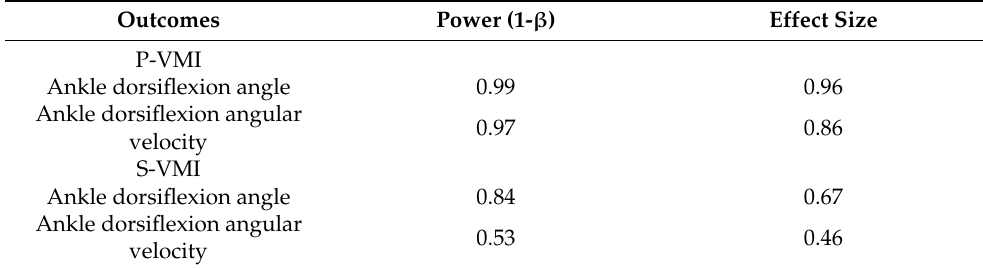
Table 1. Post hoc power calculations for primary outcomes.